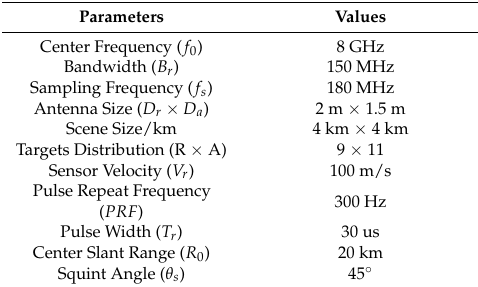
Table 3. Parameters of simulation.